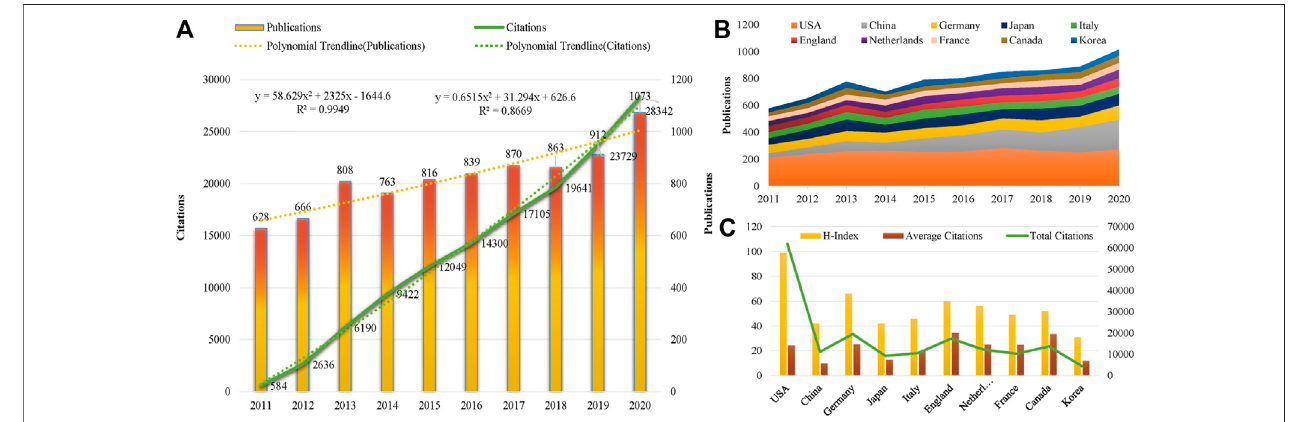
FIGURE 1 | Trends in publications and citations of vascular calci fi cation research. (A) The annual trends of global publications and citations. (B) The temporal trends of publications from the top 10 countries. (C) H-index, average citations (citations per article), and total citations of the top 10 countries.